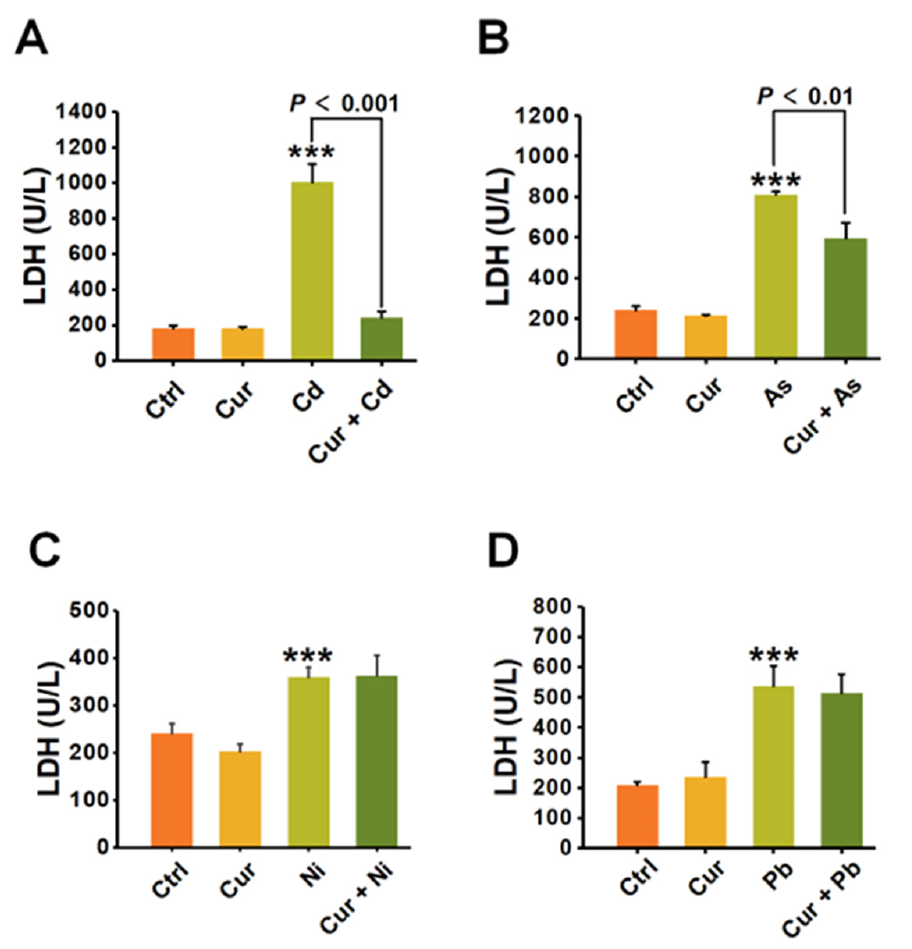
Figure 4. The impacts of curcumin on cell membrane damage induced by heavy metals ( n = 3). The HepG2 cells are pre-treated with curcumin and incubated with ( A ) Cd, ( B ) As, ( C ) Ni and ( D ) Pb, respectively. The LDH concentrations in the cell supernatants were detected for evaluating the damage to the cell membrane. The concentrations of curcumin and heavy metals were 20 µ M for curcumin, 6 µ M for Cd, 100 µ M for As, 2 mM for Ni and 2.5 mM for Pb, respectively. *** p < 0.001, compared to the untreated